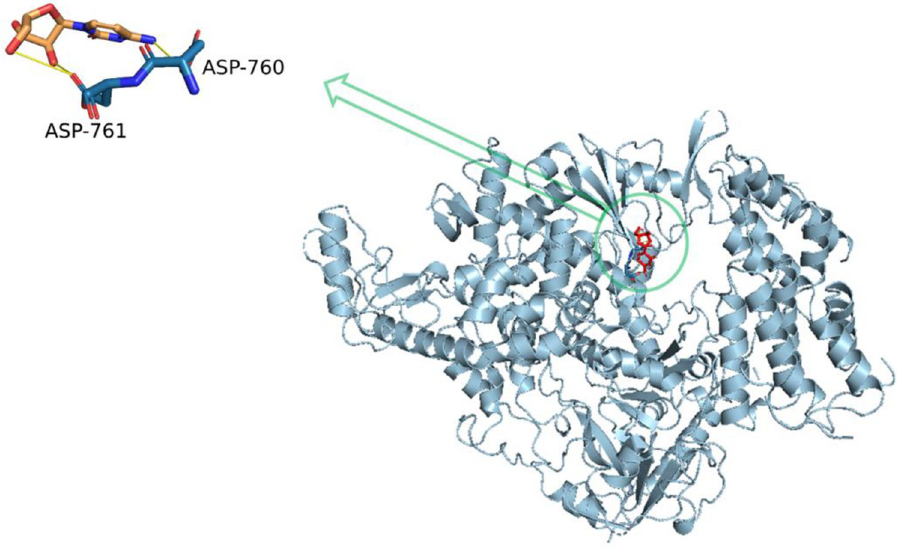
Fig 1. Cytarabine, with a -5.65 Kcal/mol, has the highest likelihood (70%) of binding to RdRp’s replicating groove (6M71). Ligands are labeled with a three-letter code, whereas protein residues are tagged with a licorice color. H-bonds are represented by solid yellow